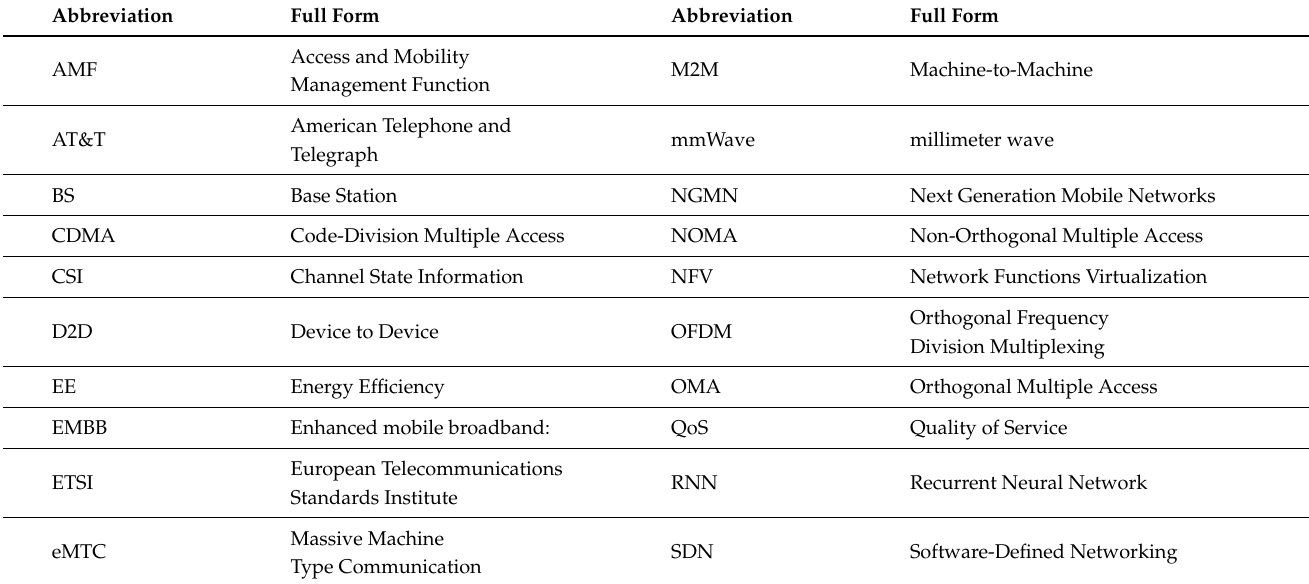
Table 2. Table of Notations and